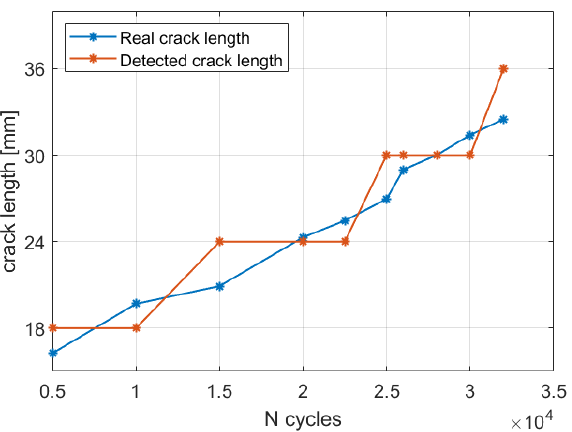
Figure 15. Crack size estimation with the 3 mm iFEM model for the whole acquisition history.